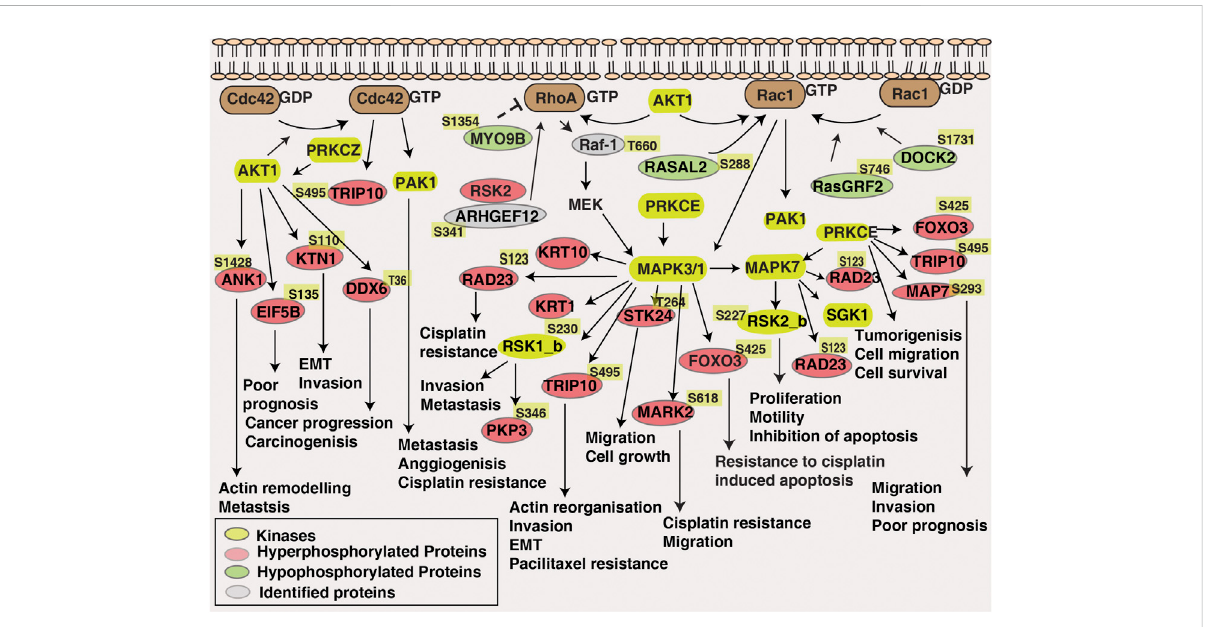
FIGURE 7 Data-driven modelofNACTresistance intonguecancerpatients. PathwayanalysisrevealedtheenrichmentofRho-GTPase signalling pathway in NACT resistant patients. Dysregulated proteins, differentially phosphorylated kinases and proteins involved in Rho-GTPase pathway is highlighted in the schematic